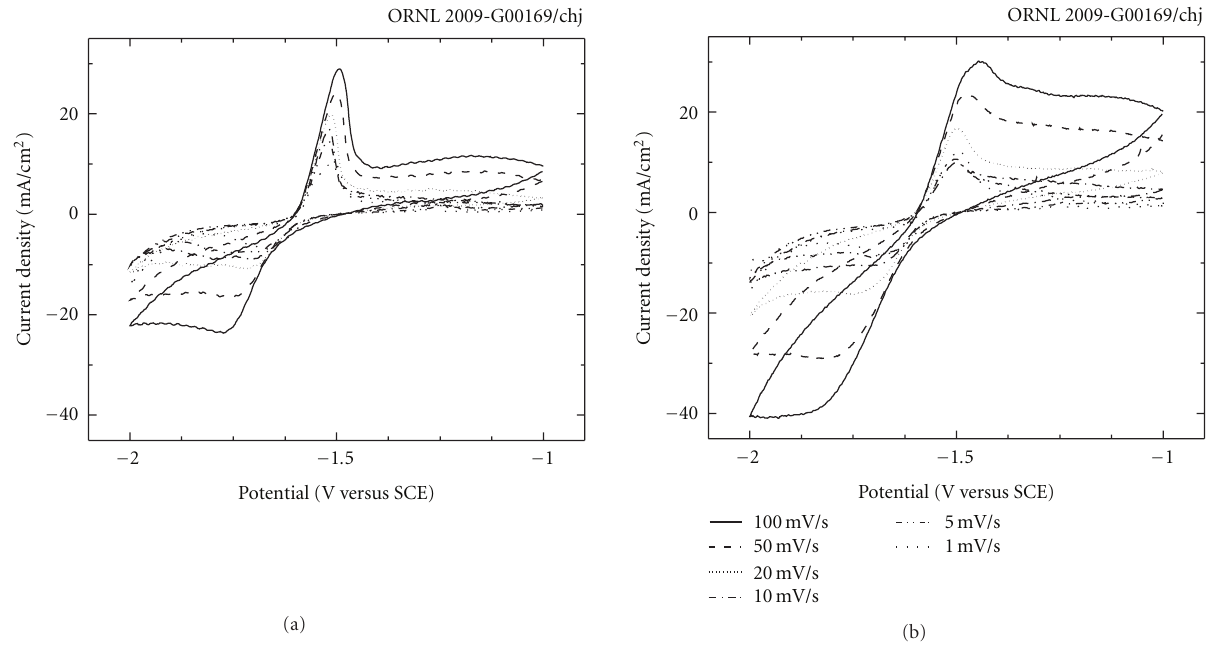
Figure 5: Current versus applied potential curves for ZnO electrode sample 4 at various scan rates in a quiet (a) and stirred (b) electrolyte.